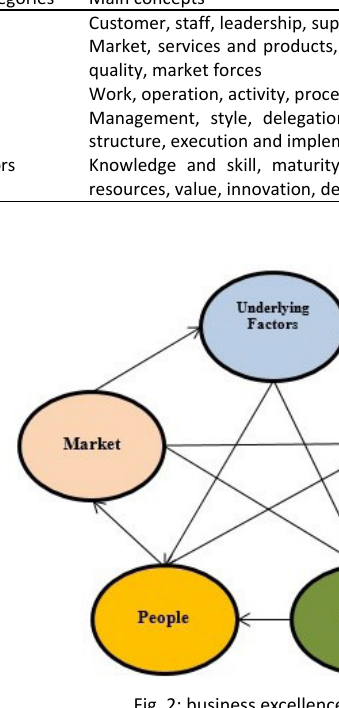
Fig. 2: business excellence model